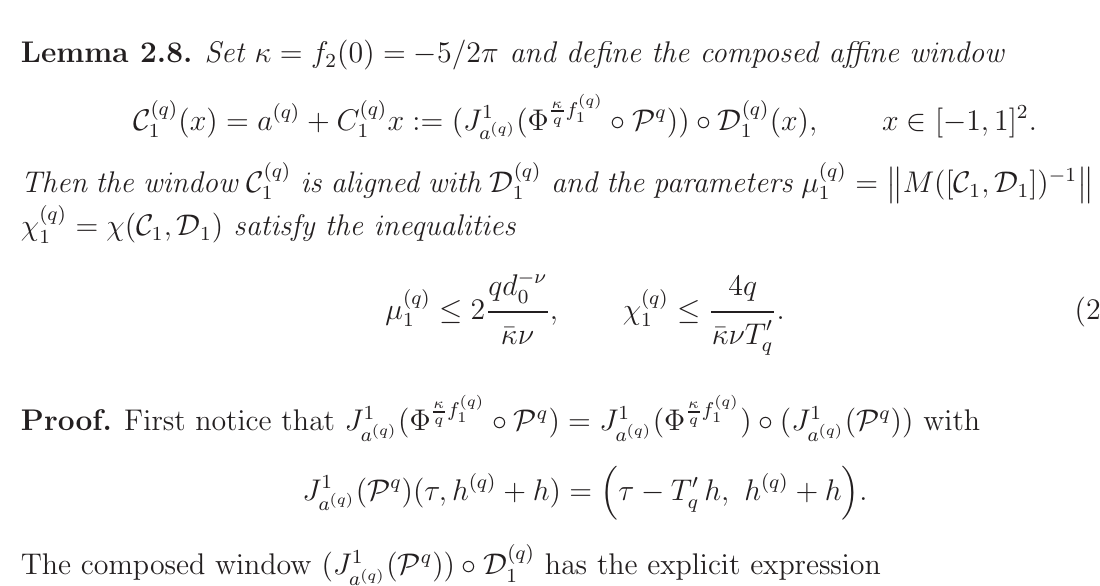
Fig. 5 The domains R ( q ) ∗ , Φ 1 q f ( q ) ( S ( q ) ∗ ) and S ( q )